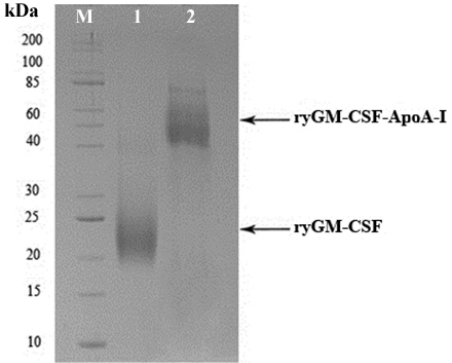
Figure 4. SDS-PAGE analysis of ryGM-CSF and ryGM-CSF-ApoA-I preparations purified by successive ion exchange chromatography steps. Lanes: ( M ) standard molecular weight marker